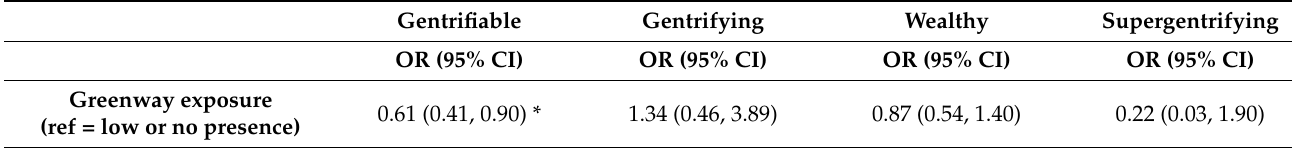
Table 4. Logistic regression models (weight-adjusted and spatial clustering) stratified by neighborhood type reporting the re- lationship between exposure to greenways and the odds of experiencing anxiety/depression, adjusted for sociodemographic variables (sex, age, ethnicity, socioeconomic status and caregiver